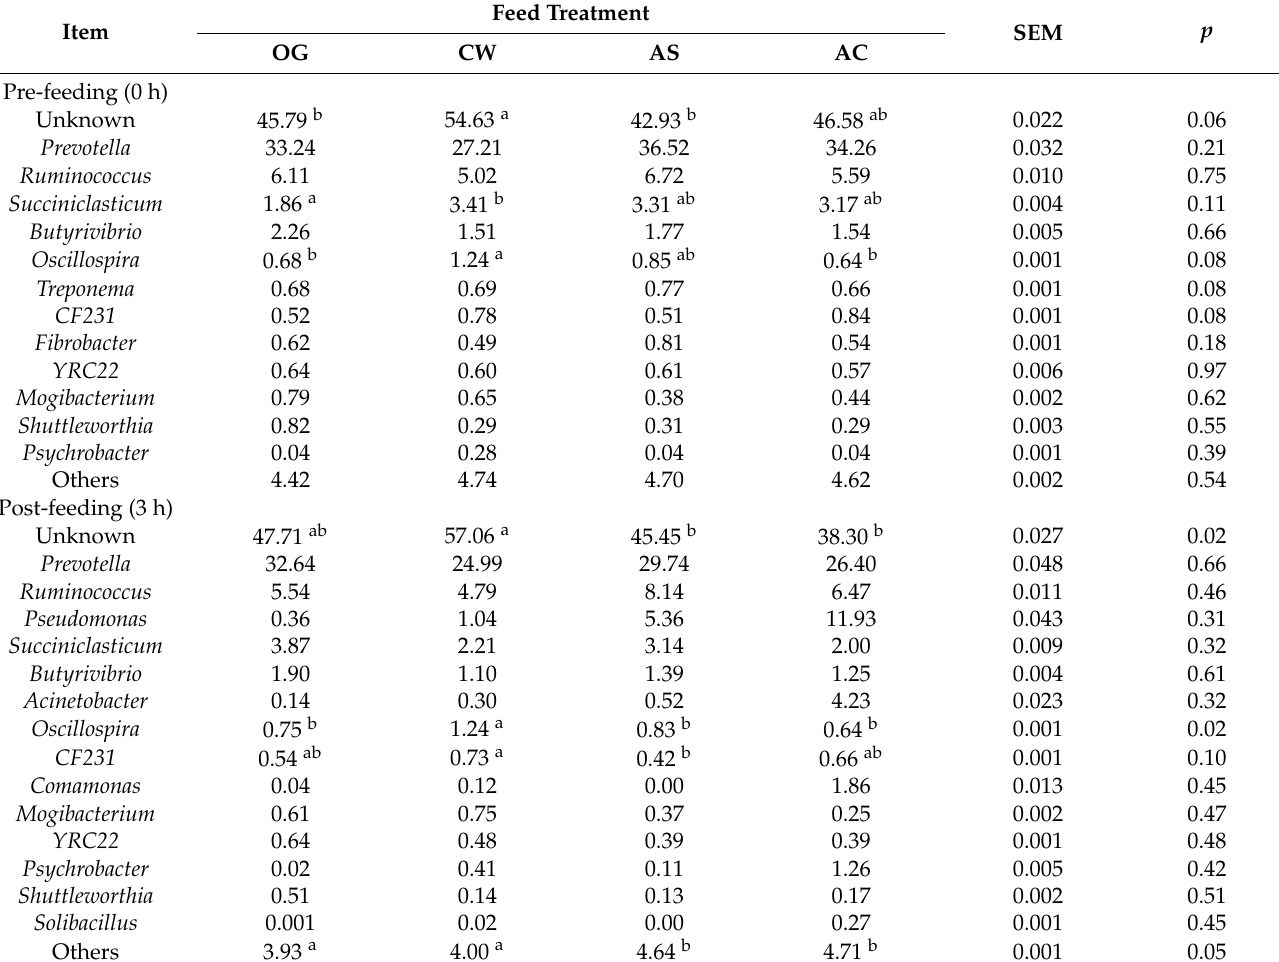
Table 9. Varied genus account for the whole testing rumen microbes pre-feeding and post-feeding.